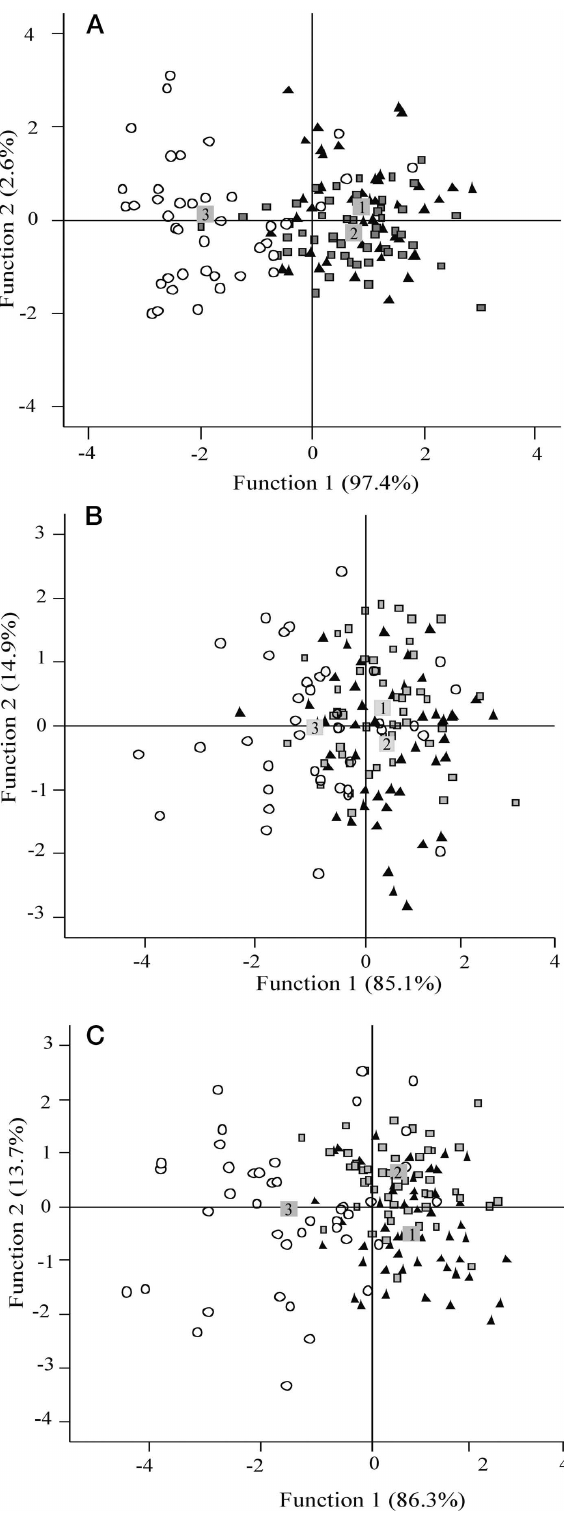
Fig . 3. – Scatter plot of the discriminant function scores from the analysis of geographic variants of Lutjanus argentiventris (A), L. guttatus (B) and L. peru (C). Black triangles, PV; Grey squares, MA; White circles, CC; Numbers over the grey squares, centroids.